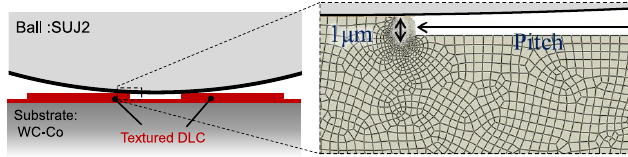
Fig. A.1. Schematic illustration of the FE model of ball on disk friction test.